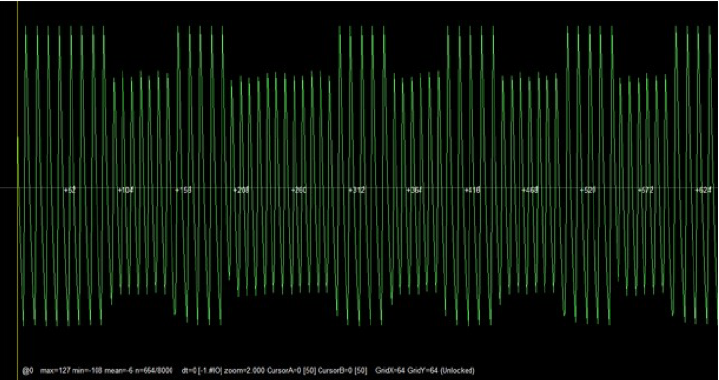
Figure 15. FSK modulated signal of the HID Proximity